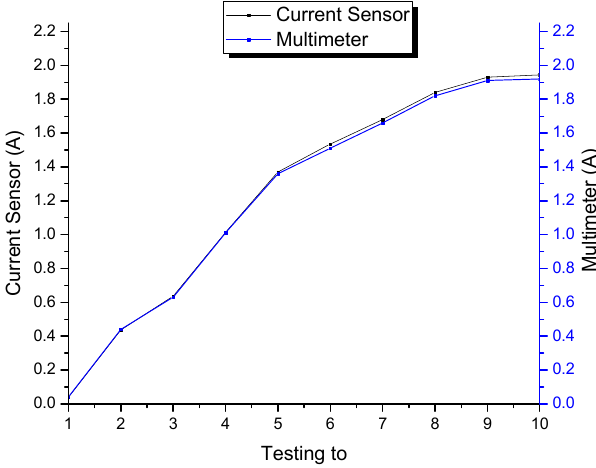
Figure 9. Test results of the current sensor.